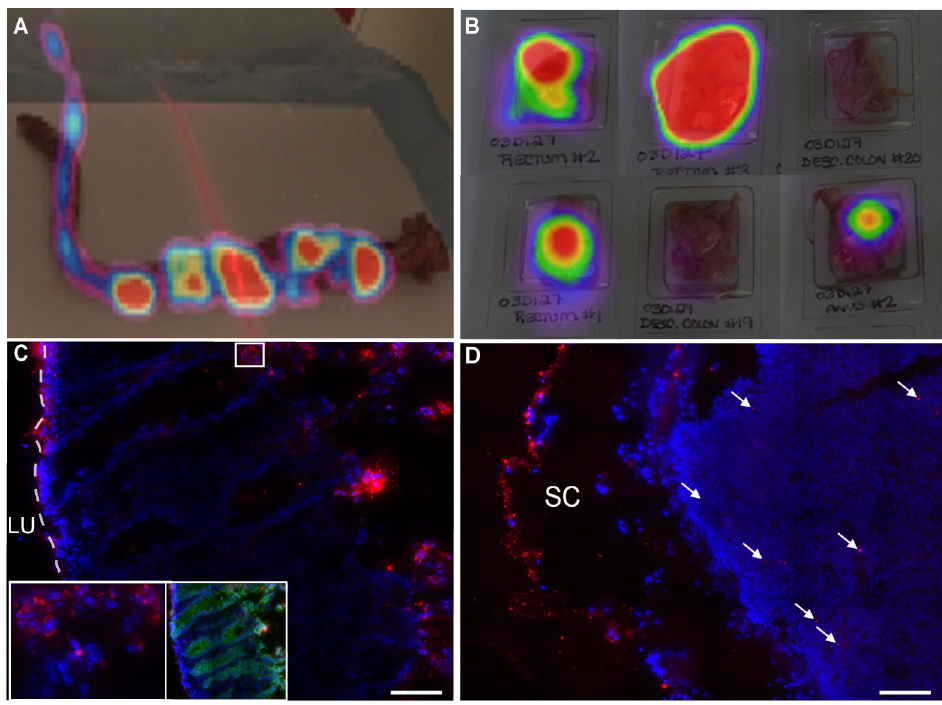
Fig 1. dIgA penetrates colon epithelium and mesenteric lymph nodes by two hours post rectal challenge. Two animals were treated rectally with either dIgA1-Cy5- 64 Cu or dIgA2-Cy5- 64 Cu, followed by challenge with PA-GFP-BaL ( Table 1 , protocol 1) After two hours, animals were sacrificed, the rectum and descending colon removed in one piece, the attached mesenteric lymph nodes separated, and the rectal and colonic tissue cut into pieces. All tissue was then frozen, cryosectioned and processed for fluorescence microscopy. Representative PET images of 64 Cu signal ( A,B ) and fluorescent microscopy images of Cy5 antibodies ( C,D ). ( A ) PET image of dIgA-C45- 64 Cu overlayed on photograph of whole, excised rectum and descending colon. ( B ) PET signal in six blocks of descending colon tissue from the dIgA1 animal ( C ) Cryosection of block of descending colon immunolabeled for E-cadherin (green, right insert). Left inset, enlargement of white boxed area in main image. ( D ) Cryosection of a single mesenteric lymph node. White arrows indicate areas of Cy5 detection (IgA) in the mesenteric lymph node. For C and D : Red, Cy5 signal; blue, Hoescht stain; LU, lumen; SC, subcapsular space. Scale bars, 40 μ m.